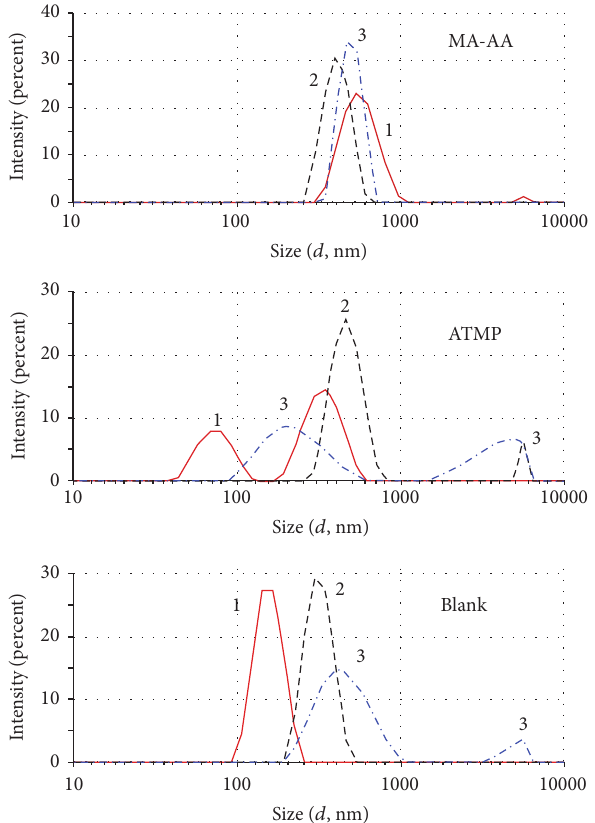
Figure 4: Gypsum particle size distribution by intensity for 0.5 mg ⋅ dm −3 MA-AA, ATMP, and a blank solution measured by DLS technique immediately after cooling ( 1 ), after 4 hours ( 2 ), and after 24 hours ( 3